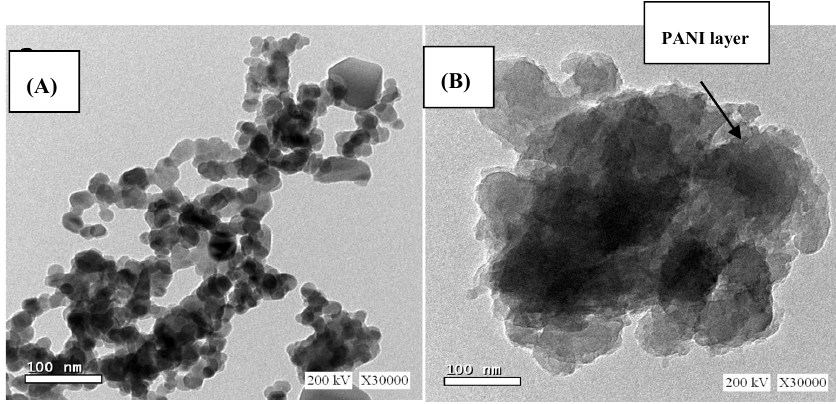
Figure 2. Images of ( A ) CuFe 2 O 4 and ( B ) CuFe 2 O 4 /PANI nano-composites.